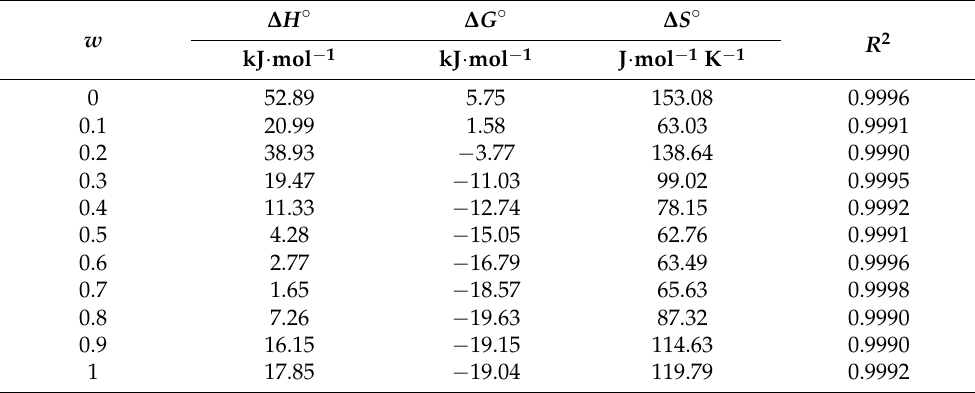
Figure 5. Enthalpy–entropy compensation analysis in different mole fractions of 1,4-dioxane ( w ) in (1,4-dioxane + water) mixture at a T hm = 308.15 K. Mole fraction of 1,4-dioxane ( w ) in a (1,4-dioxane + water) mixture from 0 to 1. Table 10. Apparent thermodynamic parameters for the dissolution behavior of GLN in a 1,4-dioxane ( w ) + water (1 − w )